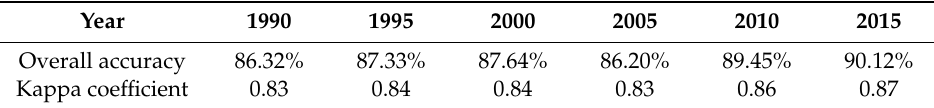
Table 11. Assessment indexes of classification accuracy.